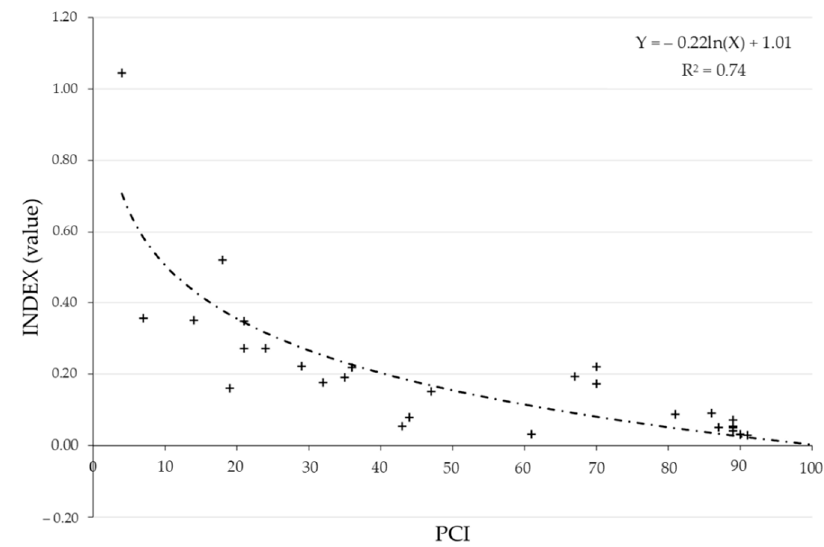
Figure 9. Correlation between PCI and I ROADS .